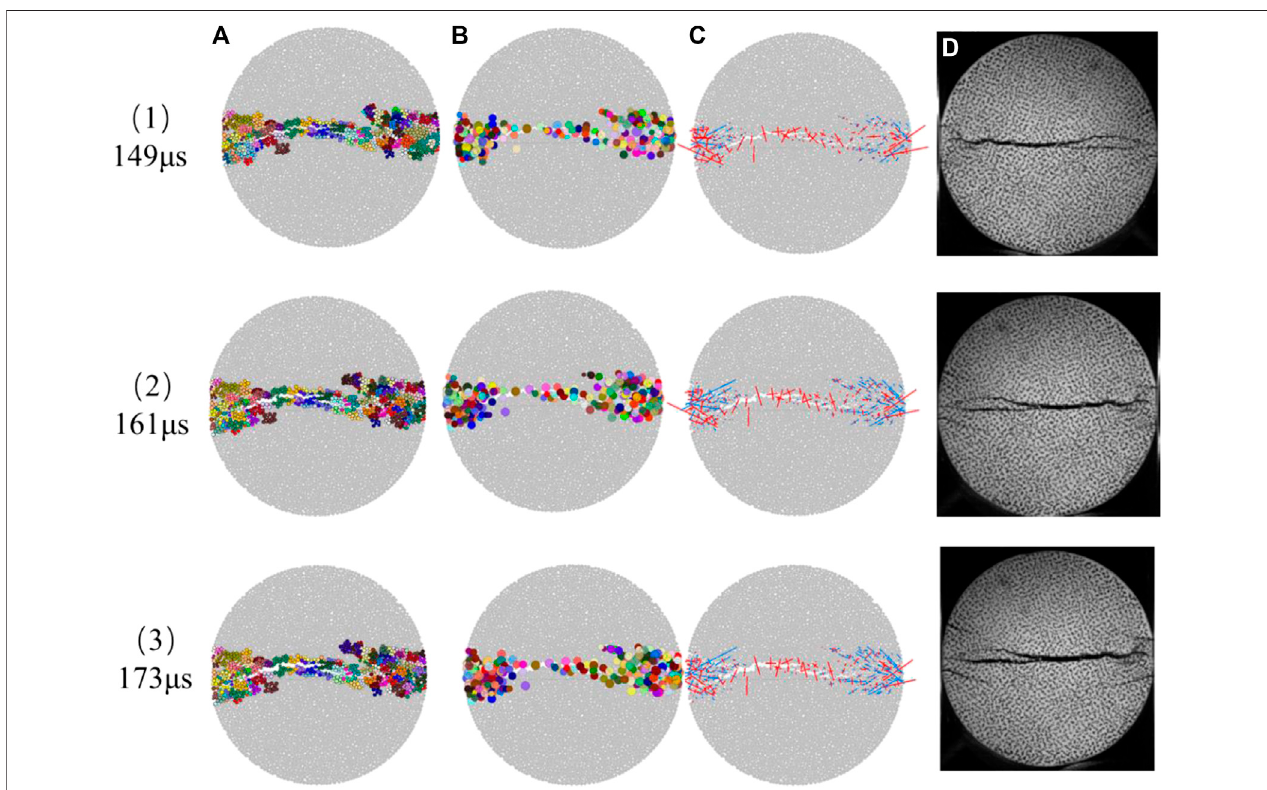
FIGURE 9| The results ofAE location, moment tensor in simulation, and HS photography before and after the shear failure zones. (A) – (D) of Figure 9 correspond to the same fi gure values as Figure 8 .